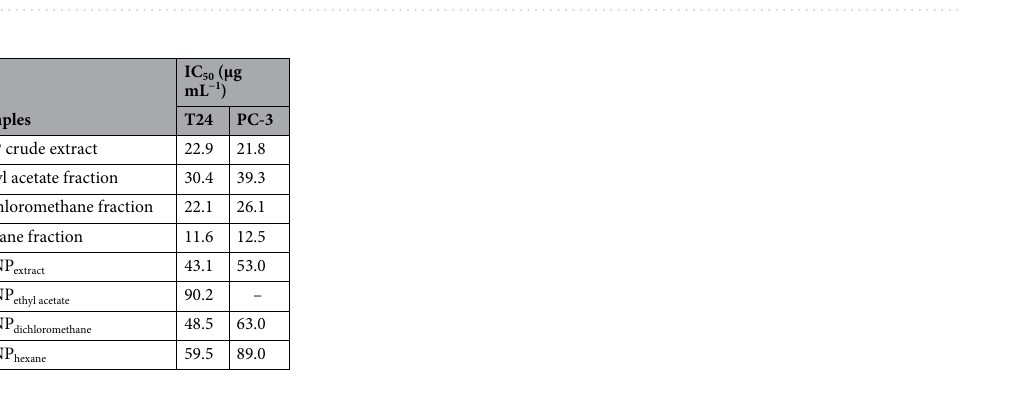
Figure 8. Cytotoxicity assay of extract and its fractions and biosynthesized gold nanoparticle in cells ( a , b ) PC-3 and ( c , d ) T24, obtained by resazurin assay.